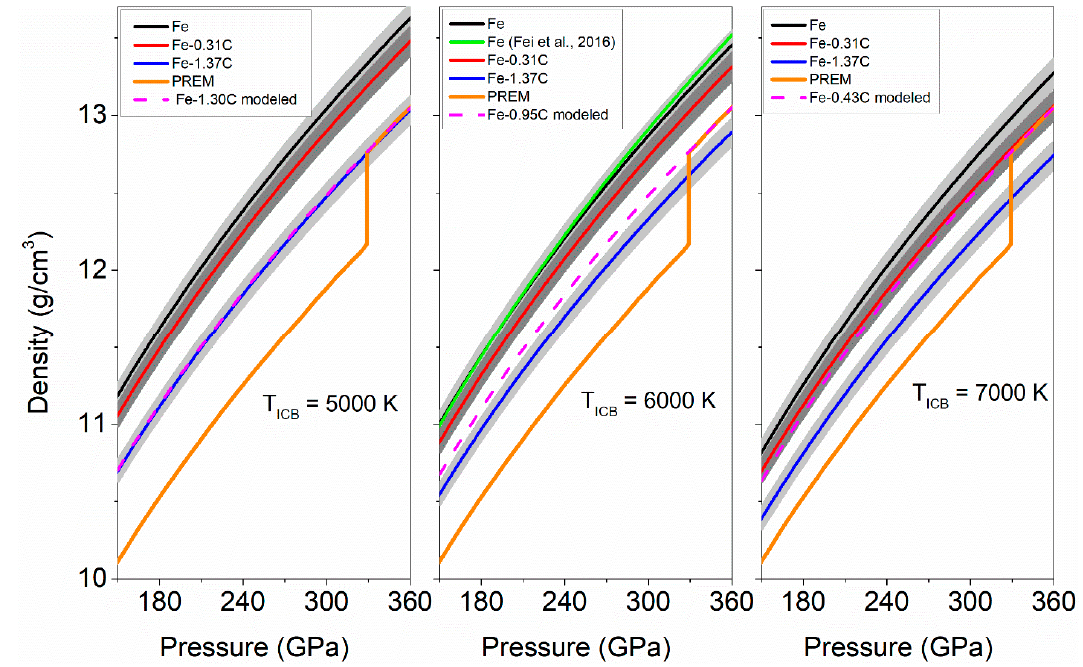
Figure 4. The calculated densities of hcp-Fe with 0, 0.31 and 1.37 wt % of carbon along the adiabatic geotherm with fixed temperatures of 5000, 6000 and 7000 K at the inner core boundary (T ICB ), compared with density profile of the core from PREM. Black, red and blue solid lines represent the density profile of pure Fe, Fe-0.31C and Fe-1.37C, respectively. The grey shaded area represents the propagated uncertainties for extrapolated density. The green line is the literature data for pure Fe along the adiabatic geotherm with a fixed temperature of 6000 K at the inner core boundary (Fei et al., 2016 [27]). The orange line represents the density profile of PREM seismic model. The dashed magenta line represent the modeled densities of Fe contains 1.30(7) 0.95 (5) and 0.43(10) wt % carbon at 5000, 6000, and 7000 K of T ICB that can reconcile the density profile of the PREM.